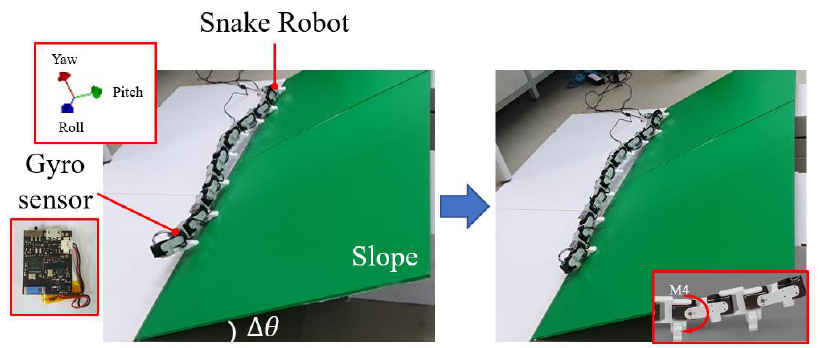
Figure 7. Experiment configuration for verifying dynamic modeling.